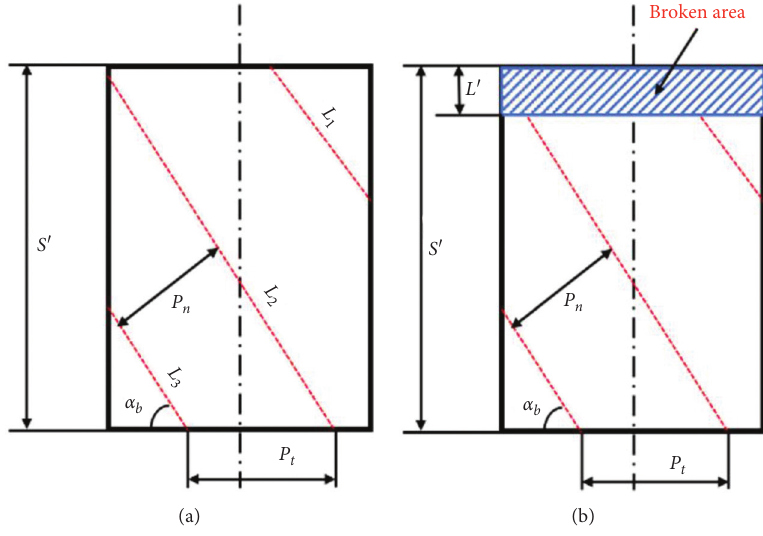
Figure 2: Diagram of meshing contact area of broken teeth.